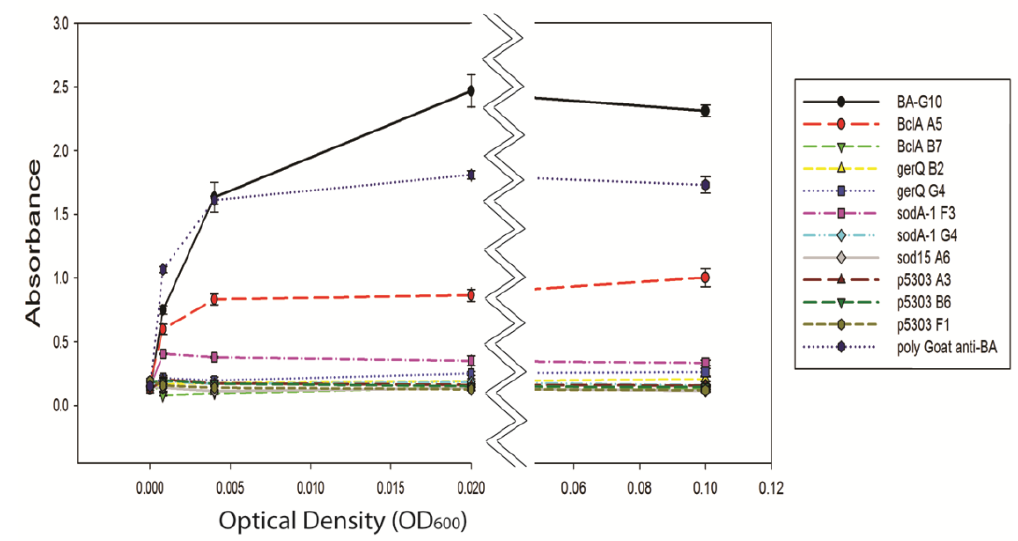
Figure 6. Limit of detection for intact B. anthracis Sterne strain spores assessed using a direct binding ELISA